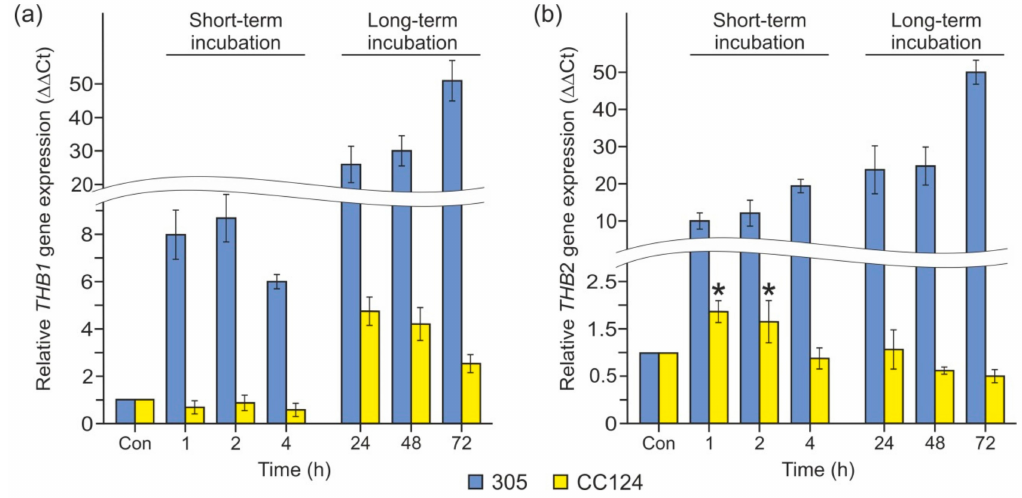
Figure 3. Expression analysis of the THB1 and THB2 genes in mutants defective in genes encoding nitrate reductase (NR) and the NIT2 transcription factor during P starvation. ( a ) THB1 expression levels in the 305 ( nit1 ) and CC124 ( nit1nit2 ) strains; ( b ) THB2 expression levels in the 305 ( nit1 ) and CC124 ( nit1nit2 ) strains. In ( a , b ), the levels of gene transcripts are calculated as times of relative abundance with respect to the housekeeping control gene ( RACK1 ), which has a value of 1. Data are the means ± SE from three biological and two technical replicates obtained by quantitative